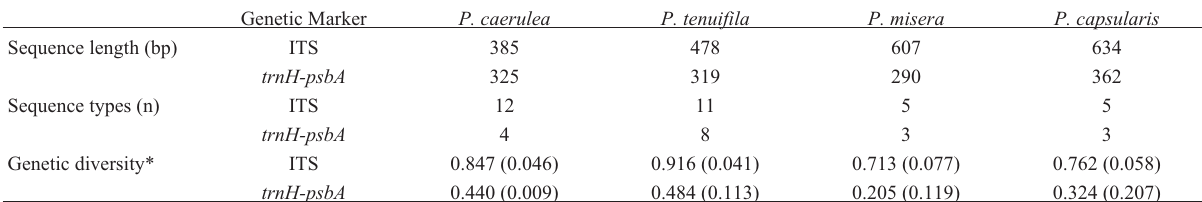
Table 2 - Characteristics of DNA sequences and summary of genetic diversity of four Passiflora species. Genetic Marker